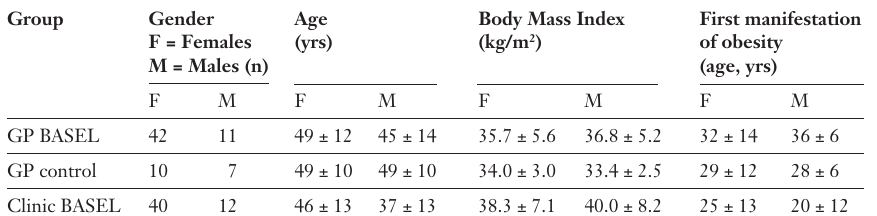
Baseline data of the subjects.